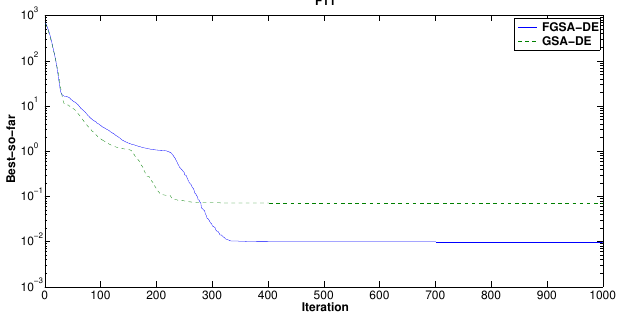
Figure 12. Comparison of the performance of FGSA-DE and GSA-DE for minimization of F 9.